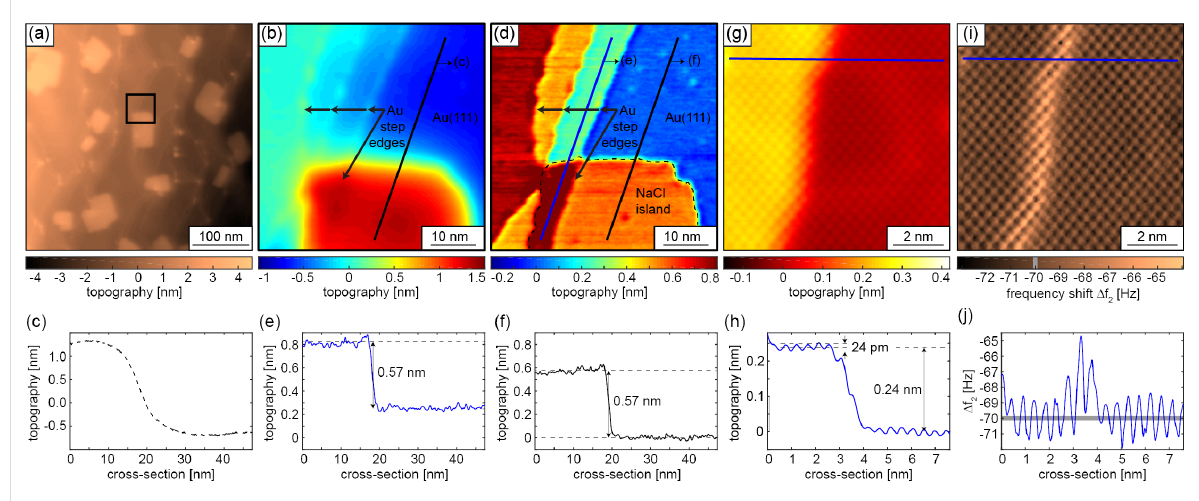
Figure 12: AFM data: (a) 400 × 400 nm 2 image of NaCl islands on a Au(111) surface scanned with the cantilever operated in its first flexural oscilla- tion mode with an amplitude A f1 , rms = 2 nm and a small negative frequency shift setpoint Δ f f1 = − 15 Hz, permitting image acquisition at a relatively large tip–sample distance for rapid overview scanning. (b, d) Smaller-scale images acquired in the first and second cantilever oscillation mode oper- ated with amplitudes A f1 , rms = 2 nm and A f2 , rms = 100 pm, respectively, at the location of the black square in panel (a), with negative frequency shift setpoints for the first and second flexural mode of Δ f f1 , f2 = − 15 Hz. Note that the NaCl islands (enclosed by the dashed line in panel (d)) runs over the lower Au(111) step edge. (c) Cross section taken at the location of the black line in panel (b). (e, f) Cross sections taken at the location of the blue and black lines in panel (d), respectively. (g) Atomic-resolution image and corresponding cross section (h) of the NaCl islands running over the Au(111) step edge measured with the second flexural mode with an oscillation amplitude A f2 , rms = 100 pm and Δ f f2 = − 70 Hz. (i) Frequency shift error image and corresponding cross section (j).